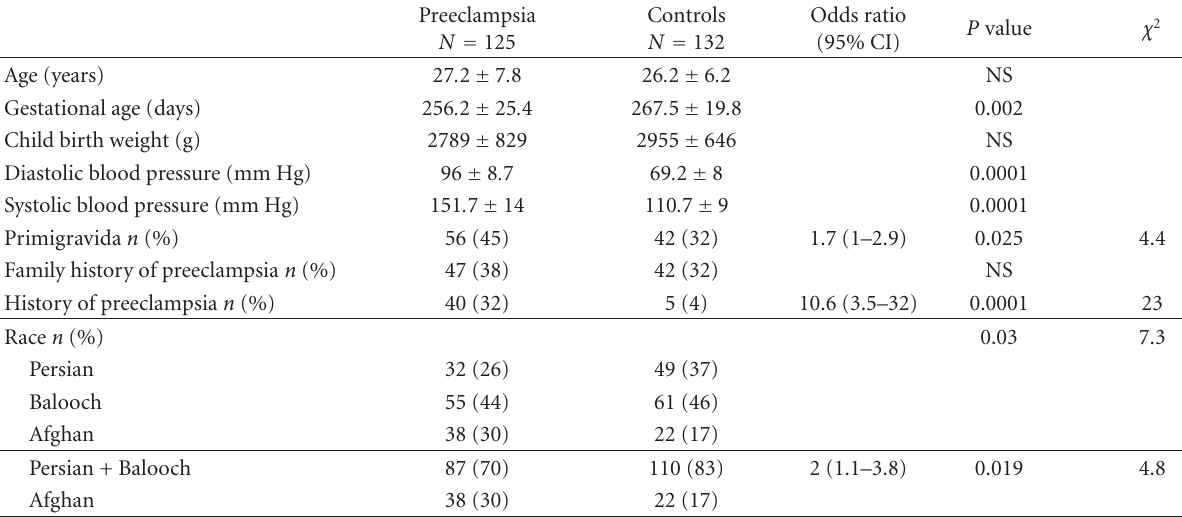
Table 1: Demographic characteristics of preeclamptic patients and controls.